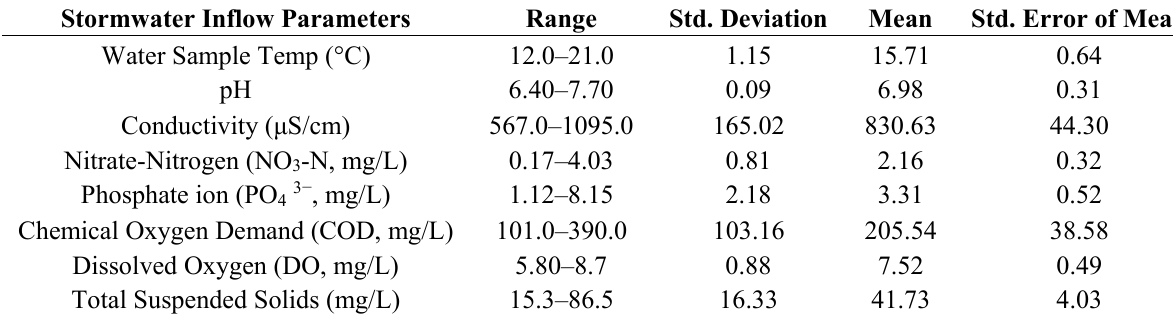
Table 2. Inflow stormwater composition and mixture (i) range (minimum–maximum); (ii) standard deviation; (iii) mean and (iv) standard error of the mean , sample number n = 80 and period of analysis (May 2012–October